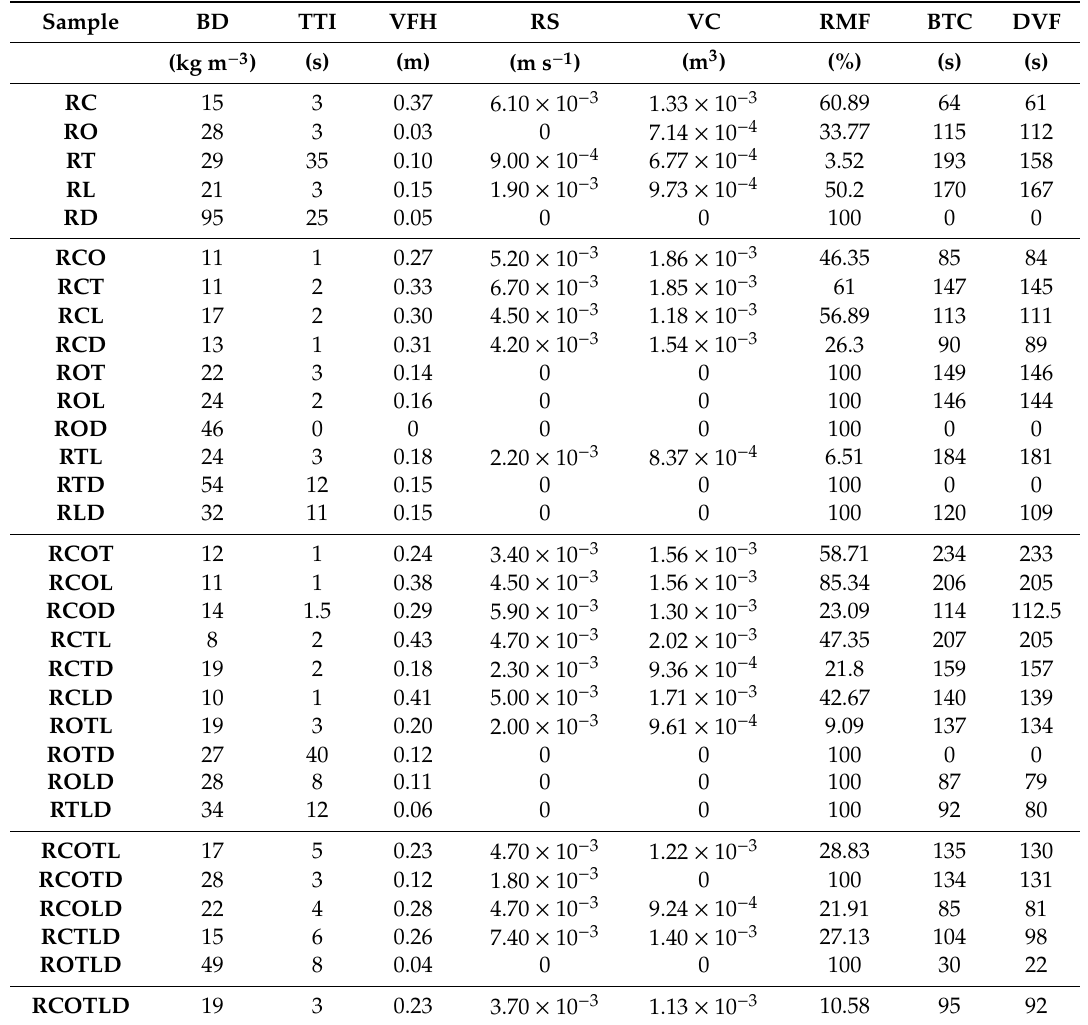
Table 5. Flammability metrics for mixtures of litter collected from Rofe Park (R) as specified by a simplex centroid design. The materials include: Allocasuarina littoralis cladodes (C), other (bark, hard woody fruits) (O), twigs (T), leaves (L), and decomposed material (D). Flammability metrics are: bulk density (BD), time-to-ignition (TTI), vertical flame height (VFH), rate of spread (RS), volume consumed (VC), residual mass fraction (RMF), burn to completion (BTC), and duration of visual flaming